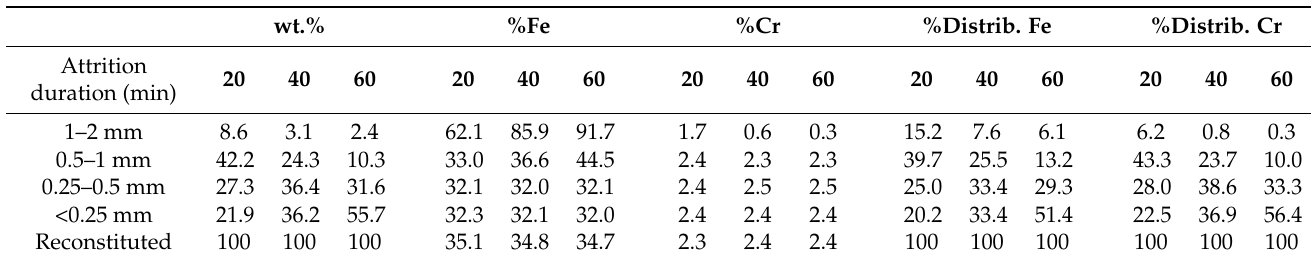
Table 5. Mass balance of the attrition step performed with several attrition durations on the mag- netic